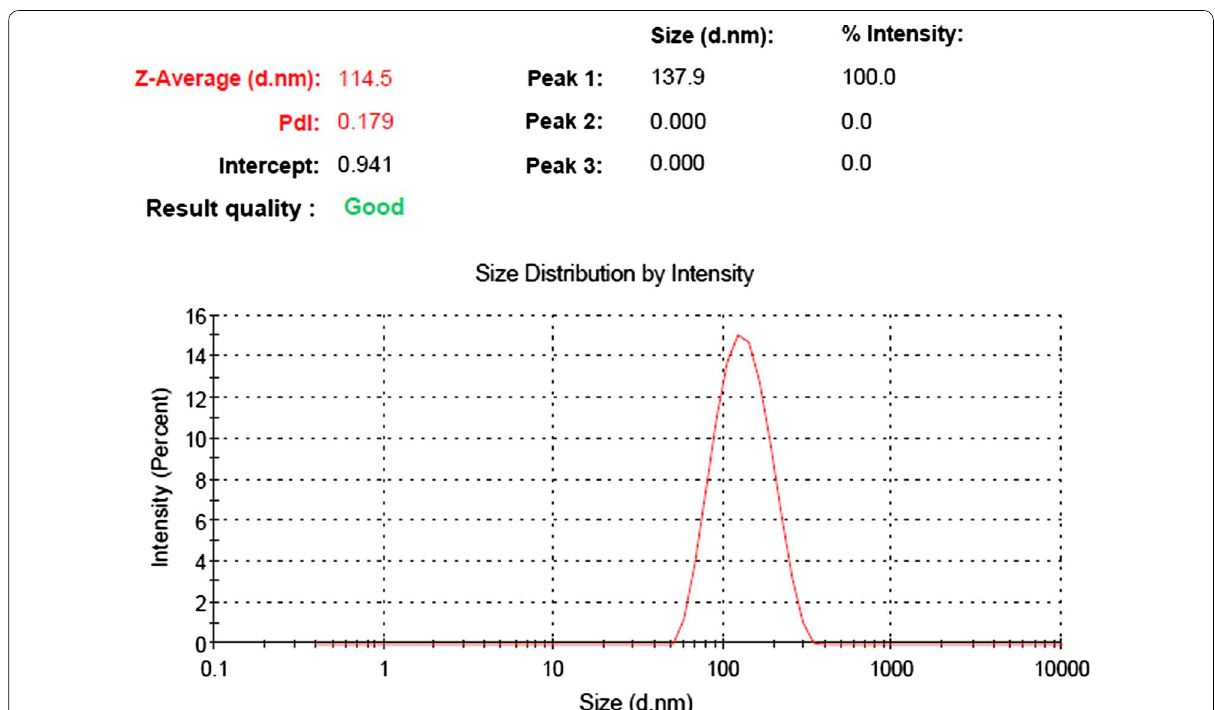
Fig. 7 Size distribution of Pd nanoparticle